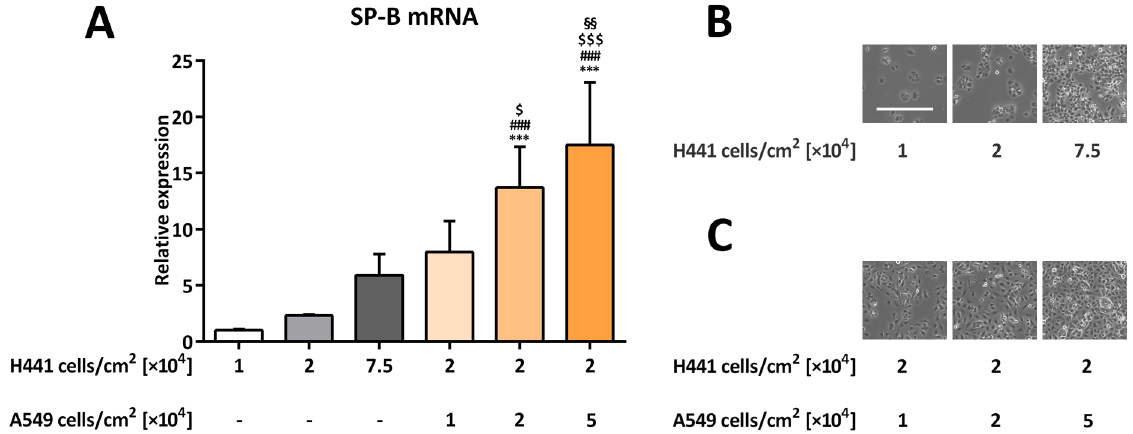
Fig 4. SP-B mRNA expression in H441 cells co-cultured with A549 cells at different cell densities. Different quantities of H441 cells were seededalone or co-cultured with different quantities of A549 cells as indicatedfor 48 h. ( A ) SP-B mRNA levels were normalizedto β -actin and fold differences comparedto 1 × 10 4 H441 cells per cm 2 without A549 cells were calculated. Means +SD of n = 4 independent experiments are shown. ( B , C ) Representative bright field images of H441 cells alone ( B ) or co-cultured with A549 cells ( C ). The bar in the upper left image represents500 μ m. *** p < 0.001 comparedto 1 × 10 4 H441 cells per cm 2 without A549 cells, ### p < 0.001 comparedto 2 × 10 4 H441 cells per cm 2 without A549 cells, $ p < 0.05 and $ $ $ p < 0.001 comparedto 7.5 × 10 4 H441 cells per cm 2 without A549 cells, §§ p < 0.01 comparedto 2 × 10 4 H441 cells per cm 2 co-culturedwith 1 × 10 4 A549 cells per cm 2